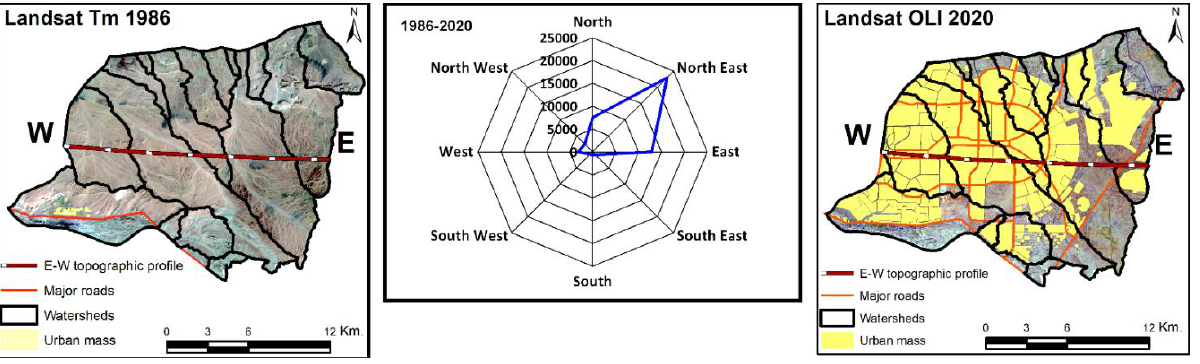
Figure 9. The overall directions of spatial urban expansions and the orientation of water divides and main valleys of the studied watersheds.